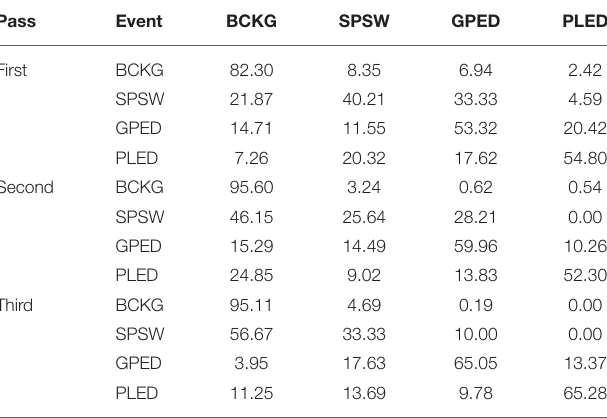
TABLE 3 | The 6-way classification results for the three passes of processing. Pass